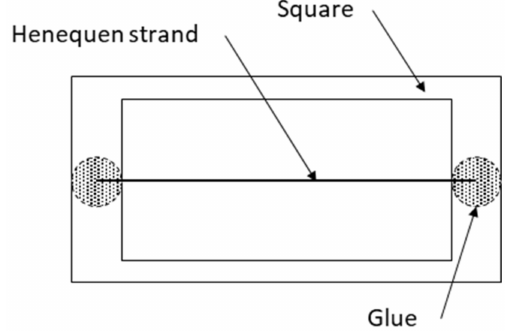
Figure 2. Filaments characterizing method.